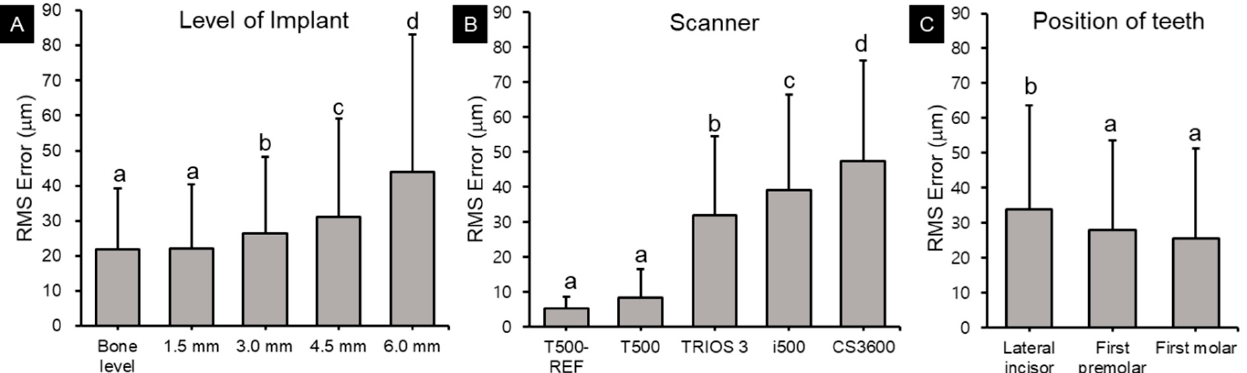
Figure 8. Precision according to implant placement depth ( A ), scanner ( B ) and tooth position ( C ). Different lowercase letters indicate significant differences within each group. Data are mean and standard deviation values.